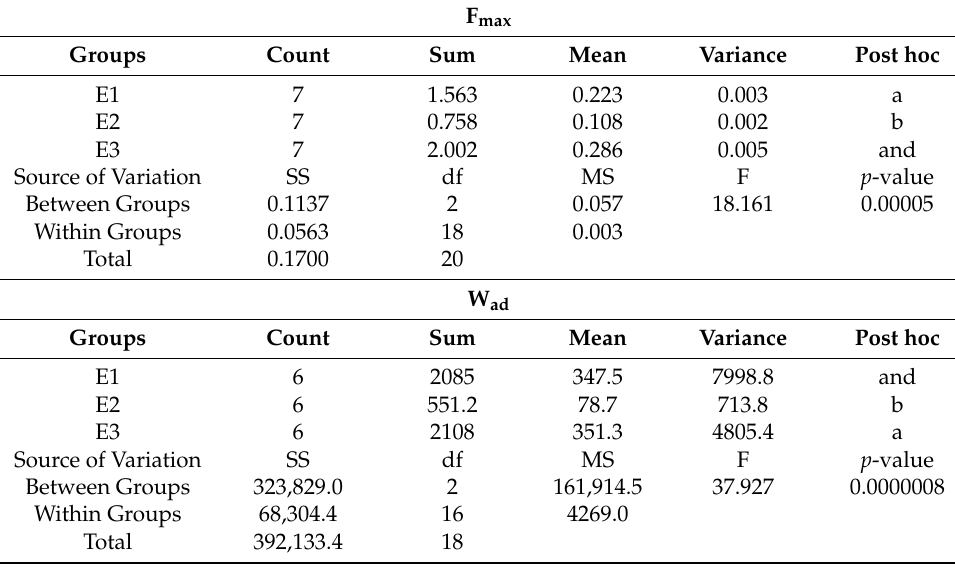
Table 7. One-way ANOVA